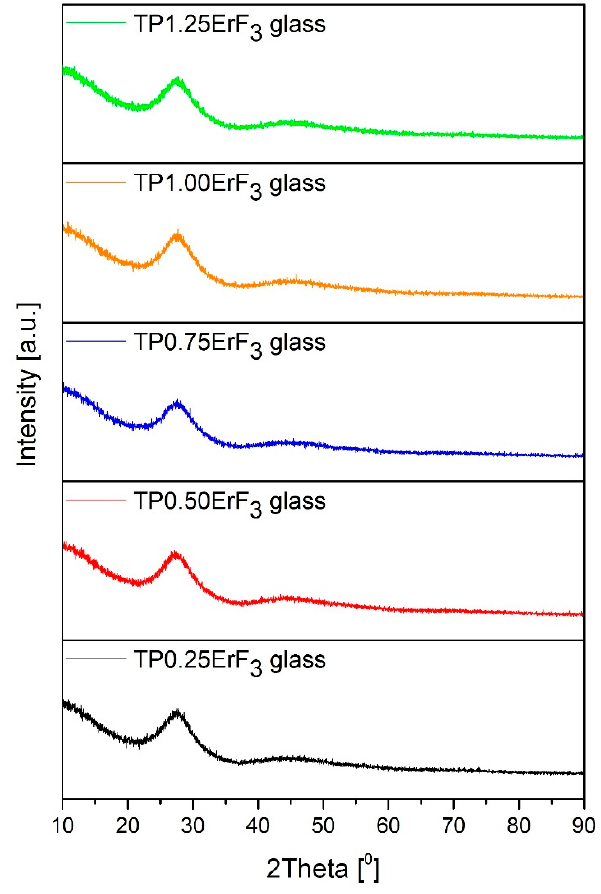
Figure 1. X-ray di ff raction patterns of oxyfluoride phospho-tellurite glass doped with erbium Figure 1. X-ray diffraction patterns of oxyfluoride phospho-tellurite glass doped with erbium trifluoride (ErF 3 trifluoride (ErF 3 ).